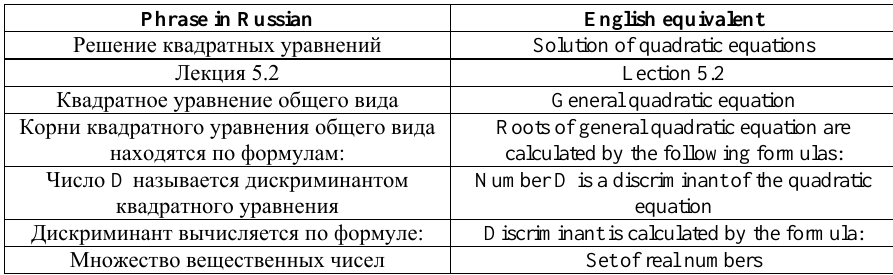
Fig. 2. A screenshot of video lection on solution of quadratic equations. Table 2. Contains of Figure